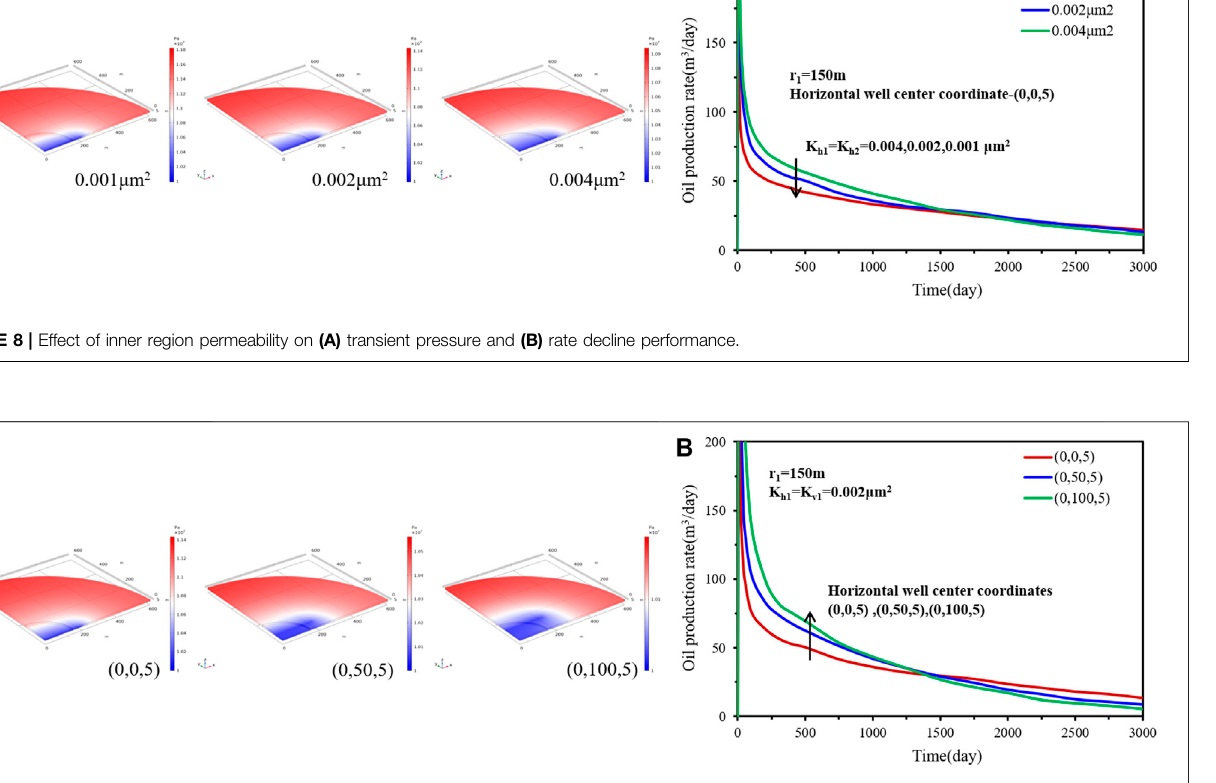
FIGURE 9 | Effect of horizontal well position on (A) transient pressure and (B) rate decline